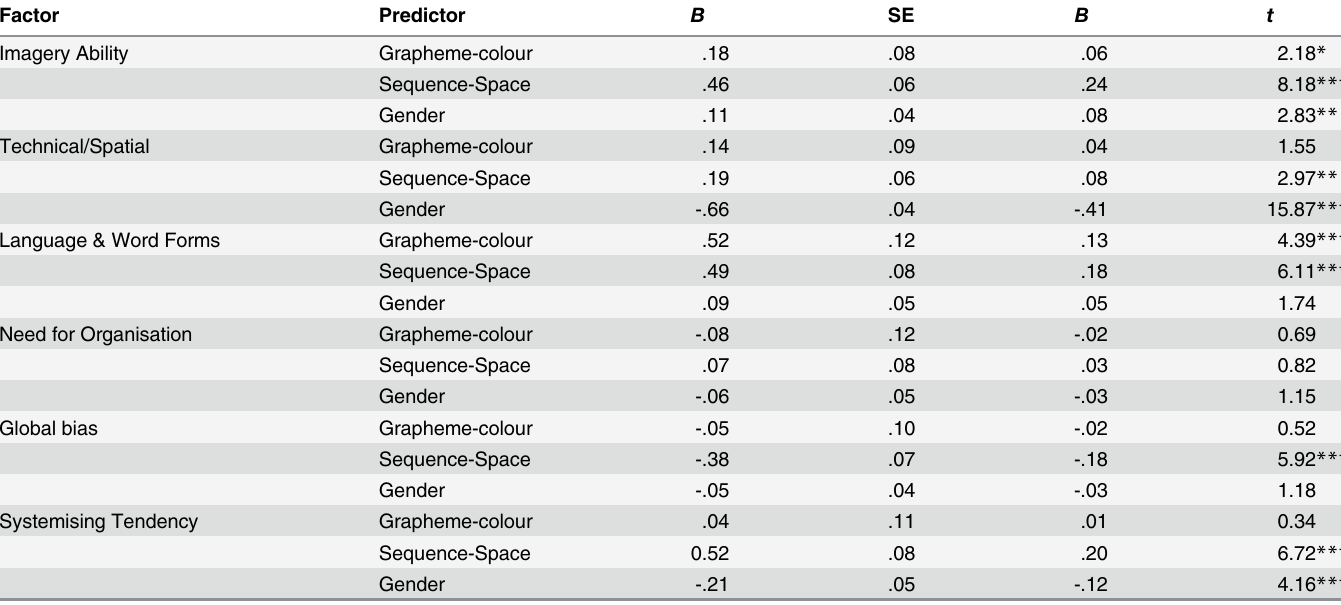
Table 7. Regression weights (unstandardised b , standard error, and standardised β ) for each subscale of the SCSQ, as a function of the presence/ absence of grapheme-colour synaesthesia, sequence-space synaesthesia, and gender.